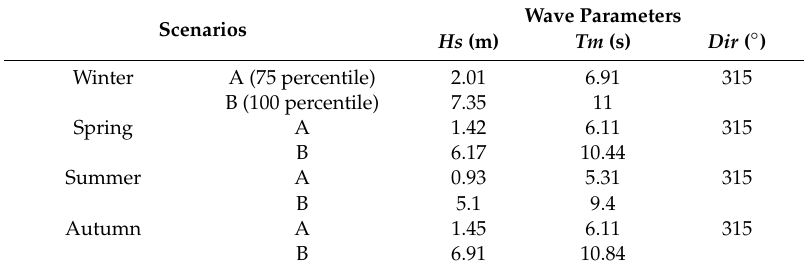
Table 2. Statistics of the wave conditions near the site O1 according to the 40-years of European Center for Medium-Range Weather Forecasts (ECMWF) wave data (January 1979 to December